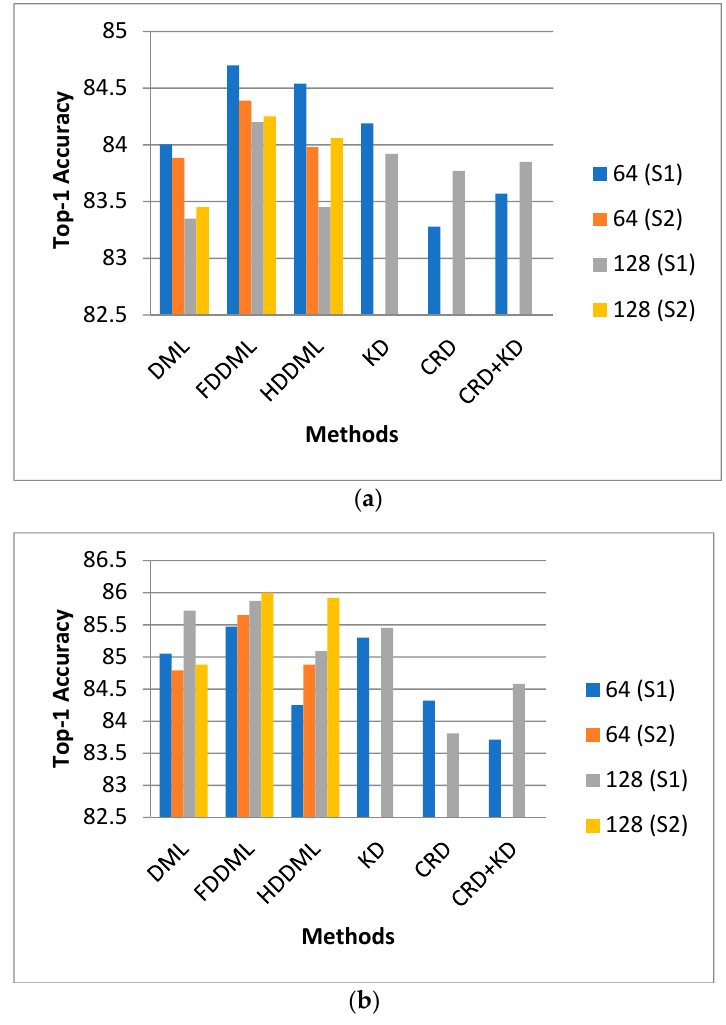
Figure 6. Comparing top ‐ 1 accuracy on Cinic ‐ 10 datasets. ( a ) WRN ‐ 40 ‐ 2 as a teacher and Resnet20 as a student when the batch size 64 and 128, and ( b ) WRN ‐ 40 ‐ 2 as a teacher and ShuffleV2 as a student when the batch size 64 and 128.